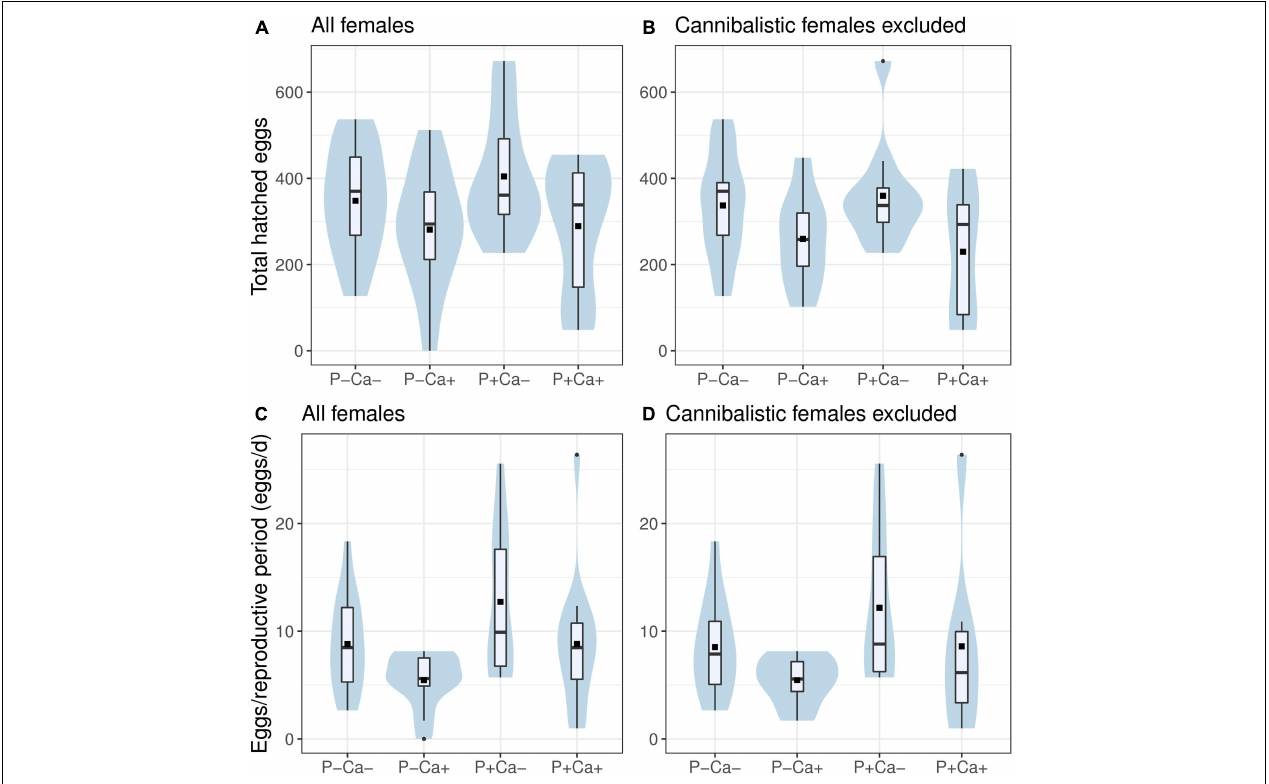
FIGURE 3 | Box-violin plots of Gryllus campestris reproductive success of all individuals (A,C) and all individuals excluding cannibalistic females (B,D) . (A,B) Total number of hatched eggs. (B,C) Female daily reproduction [hatched eggs/reproductive period (days)] for different food treatment types. Violins indicate data distribution. Boxes indicate 25, 50, and 75% quantiles, whiskers indicate all data within 1.5*IQR, 1.5 times IQR range, dots represent outliers, squares indicate group mean. P+/P–: P treatment contrasts; Ca+/Ca–: lime treatment contrasts. n = 55 for (A,C) , n = 39 for (B,D) .